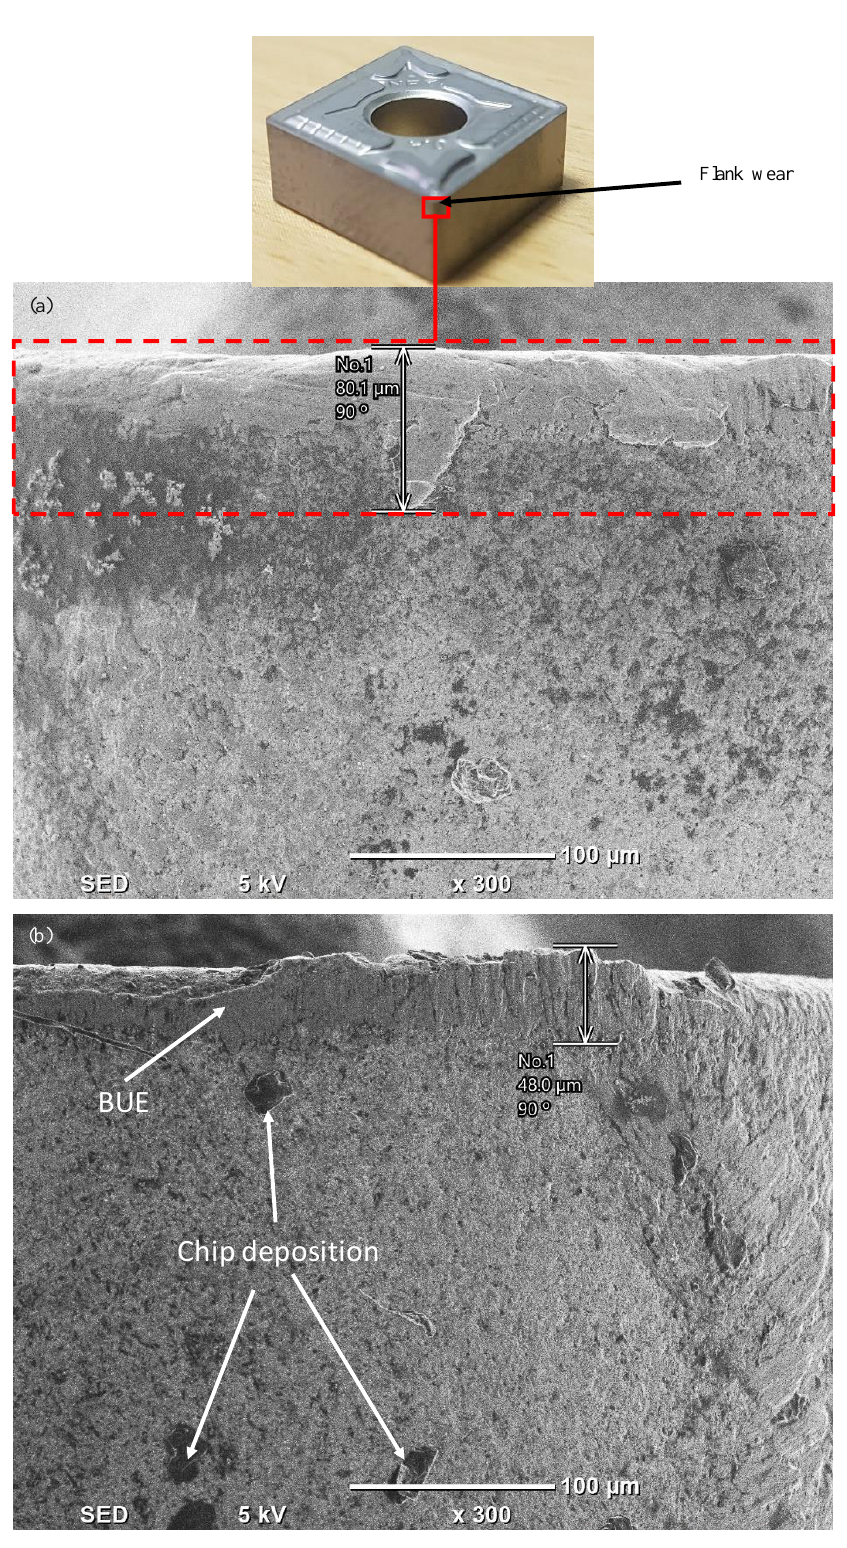
Figure 13. Flank wear for the two orientations: ( a ) AL orientation and ( b ) PL orientation at f = 0.1 mm/rev, V = 60 m/min, and d = 0.2 mm.